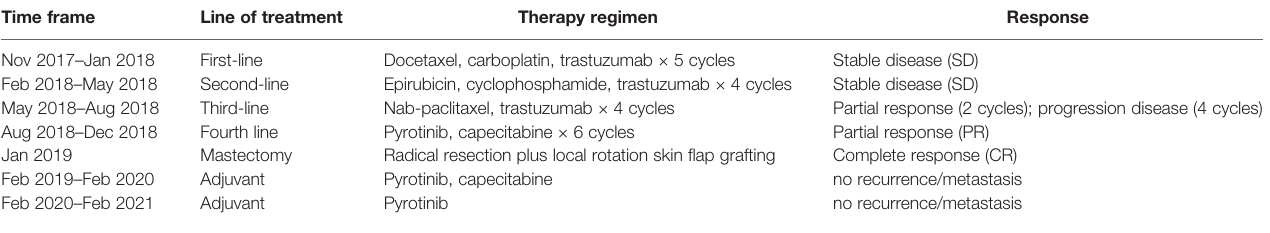
TABLE 1 | The course of disease in the patient diagnosed with breast